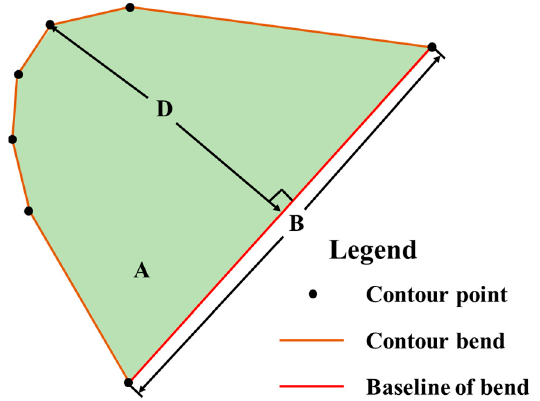
Figure 10. Three indicators of the geometric features of valleys. A is the area of the region that is colored green.